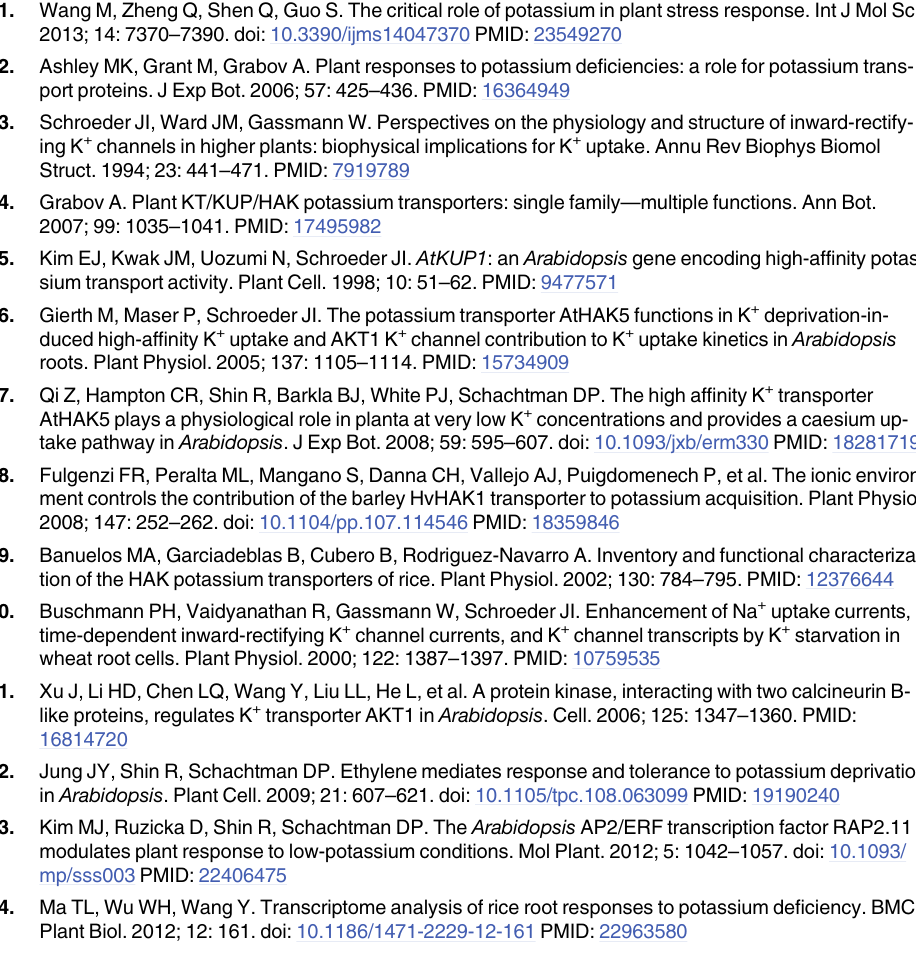
S8 Table. Genes involved in oxidative stress responses showing altered expression in sugar- cane under low-K stress. S9 Table. Genes involved in processes not listed above that are differentially expressed under low-K